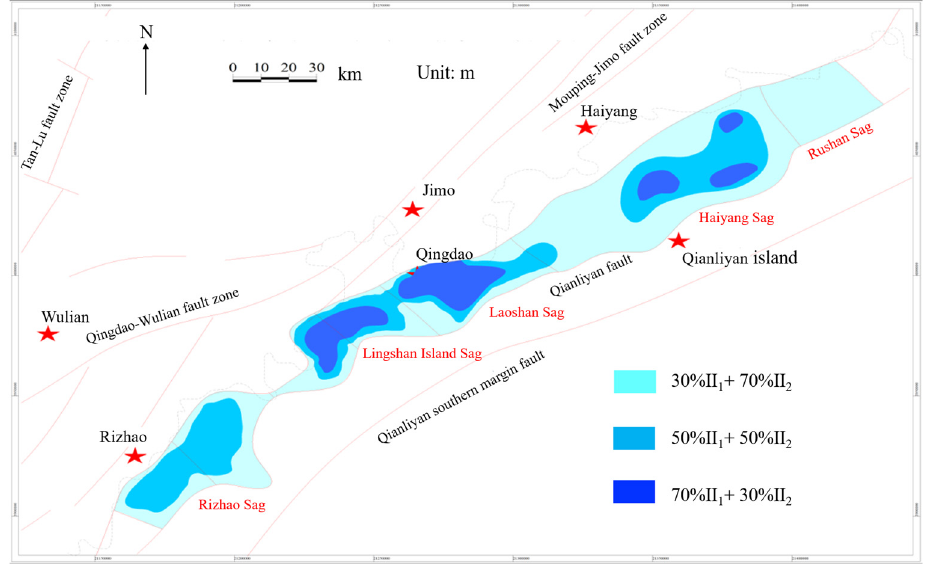
Figure 8. Distribution of the kerogen types of the Laiyang Formation source rocks in the Ri-Qing-Wei Basin.